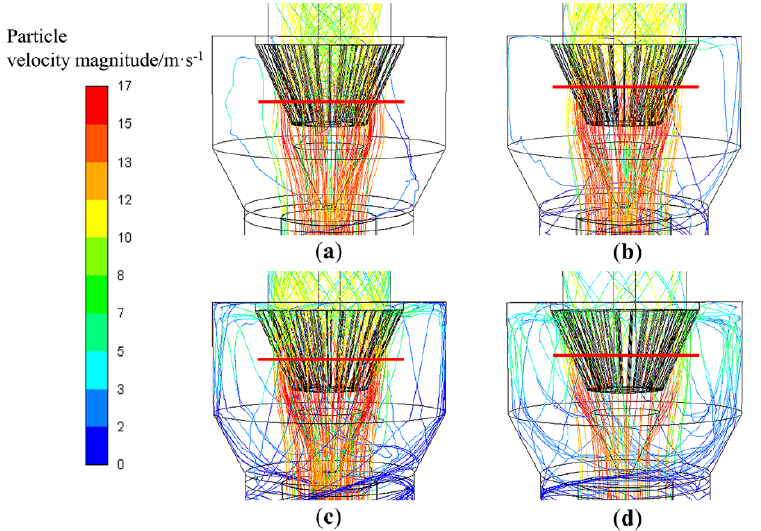
Figure 13. Trajectories of different size particles in T-F (1-0.5) : ( a ) d = 5 μ m, ( b ) d = 15 μ m, ( c ) d = 25 μ m, and ( d ) d = 35 μ m.